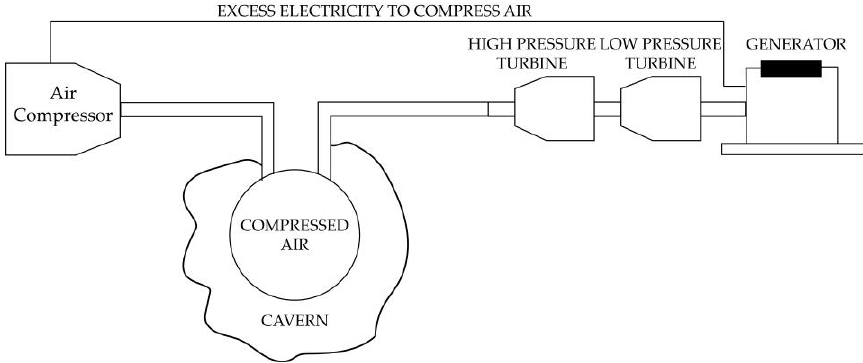
Figure 5. The principal components of a CAES station.